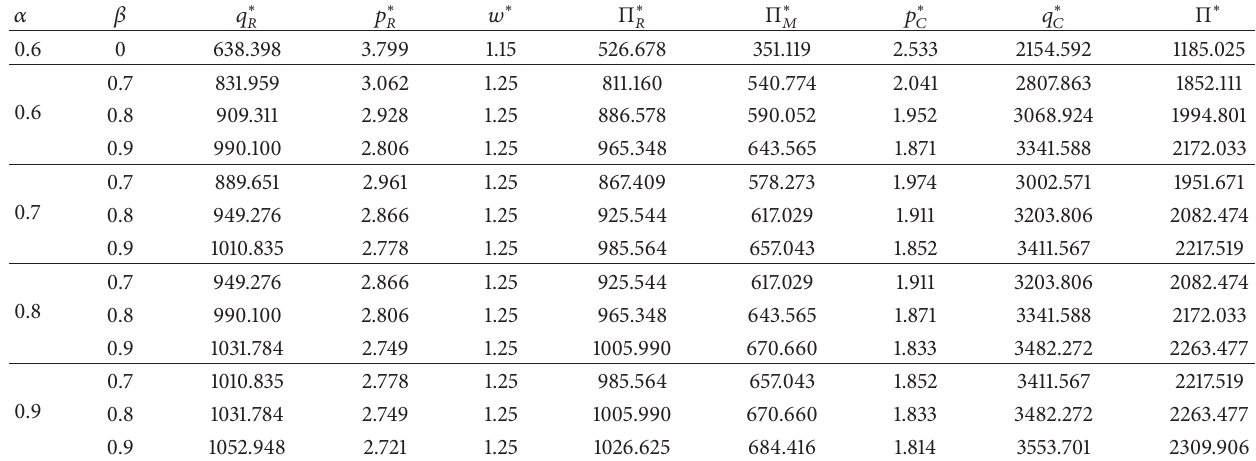
Table 3: The optimal decisions and profits with varying 𝛼 and 𝛽 .